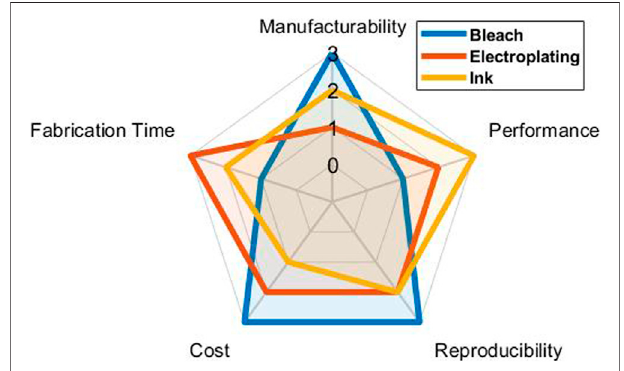
FIGURE 8 | Score of the electrode ’ s manufacturability, performance, reproducibility,cost,andfabricationtimebasedonresultsandobservationsof the current protocols for three fabrication